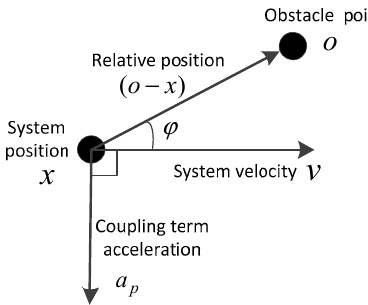
Figure 4. Motion analysis diagram of the system and obstacle.